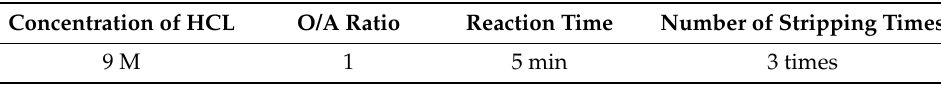
Table 5. Optimal condition of the HCl stripping experiment.